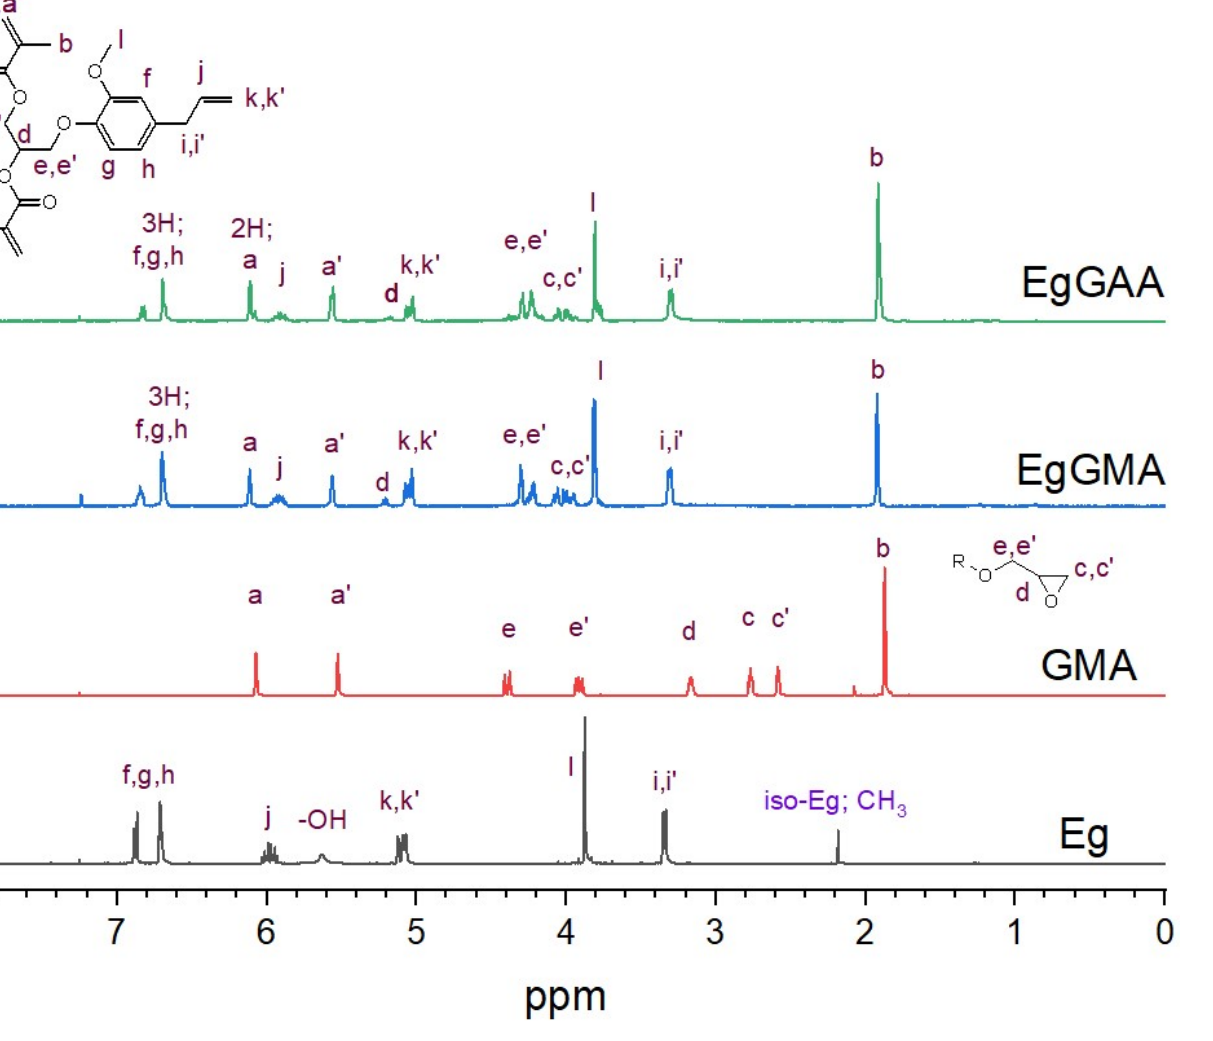
Figure 3. 1 H NMR spectra of Eg, GMA, EgGMA, and EgGAA. Peaks were marked by le tt ers as defi ned in the included structure.